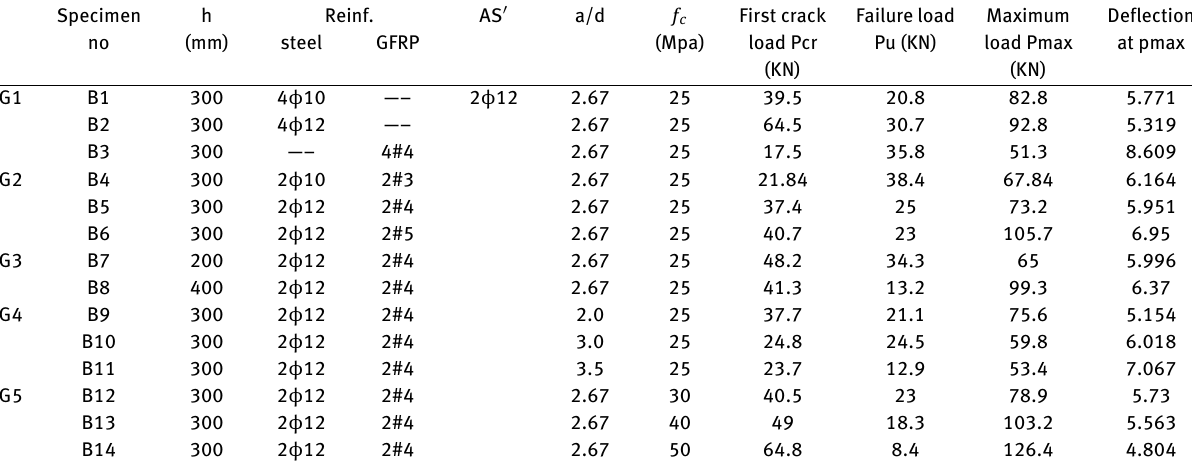
Table 1: The experimental program and results